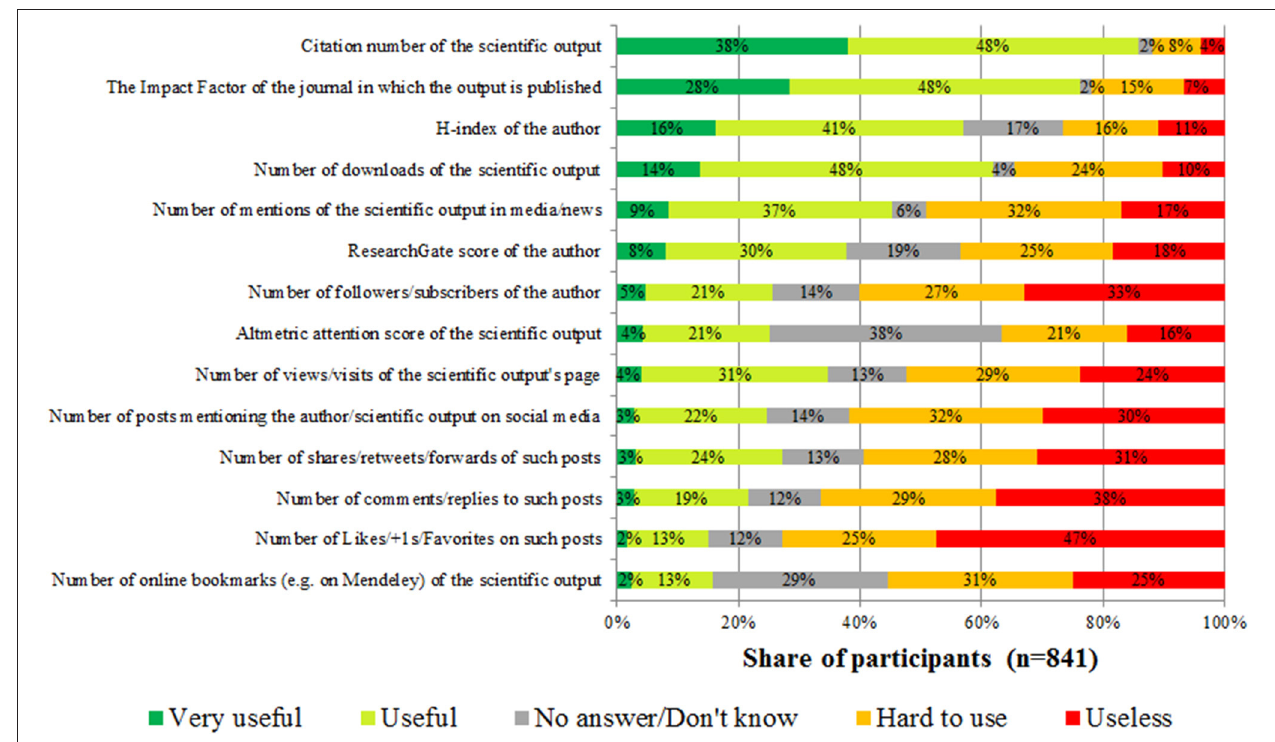
FIGURE 5 | Perceived usefulness of different types of research impact metrics for social scientists.